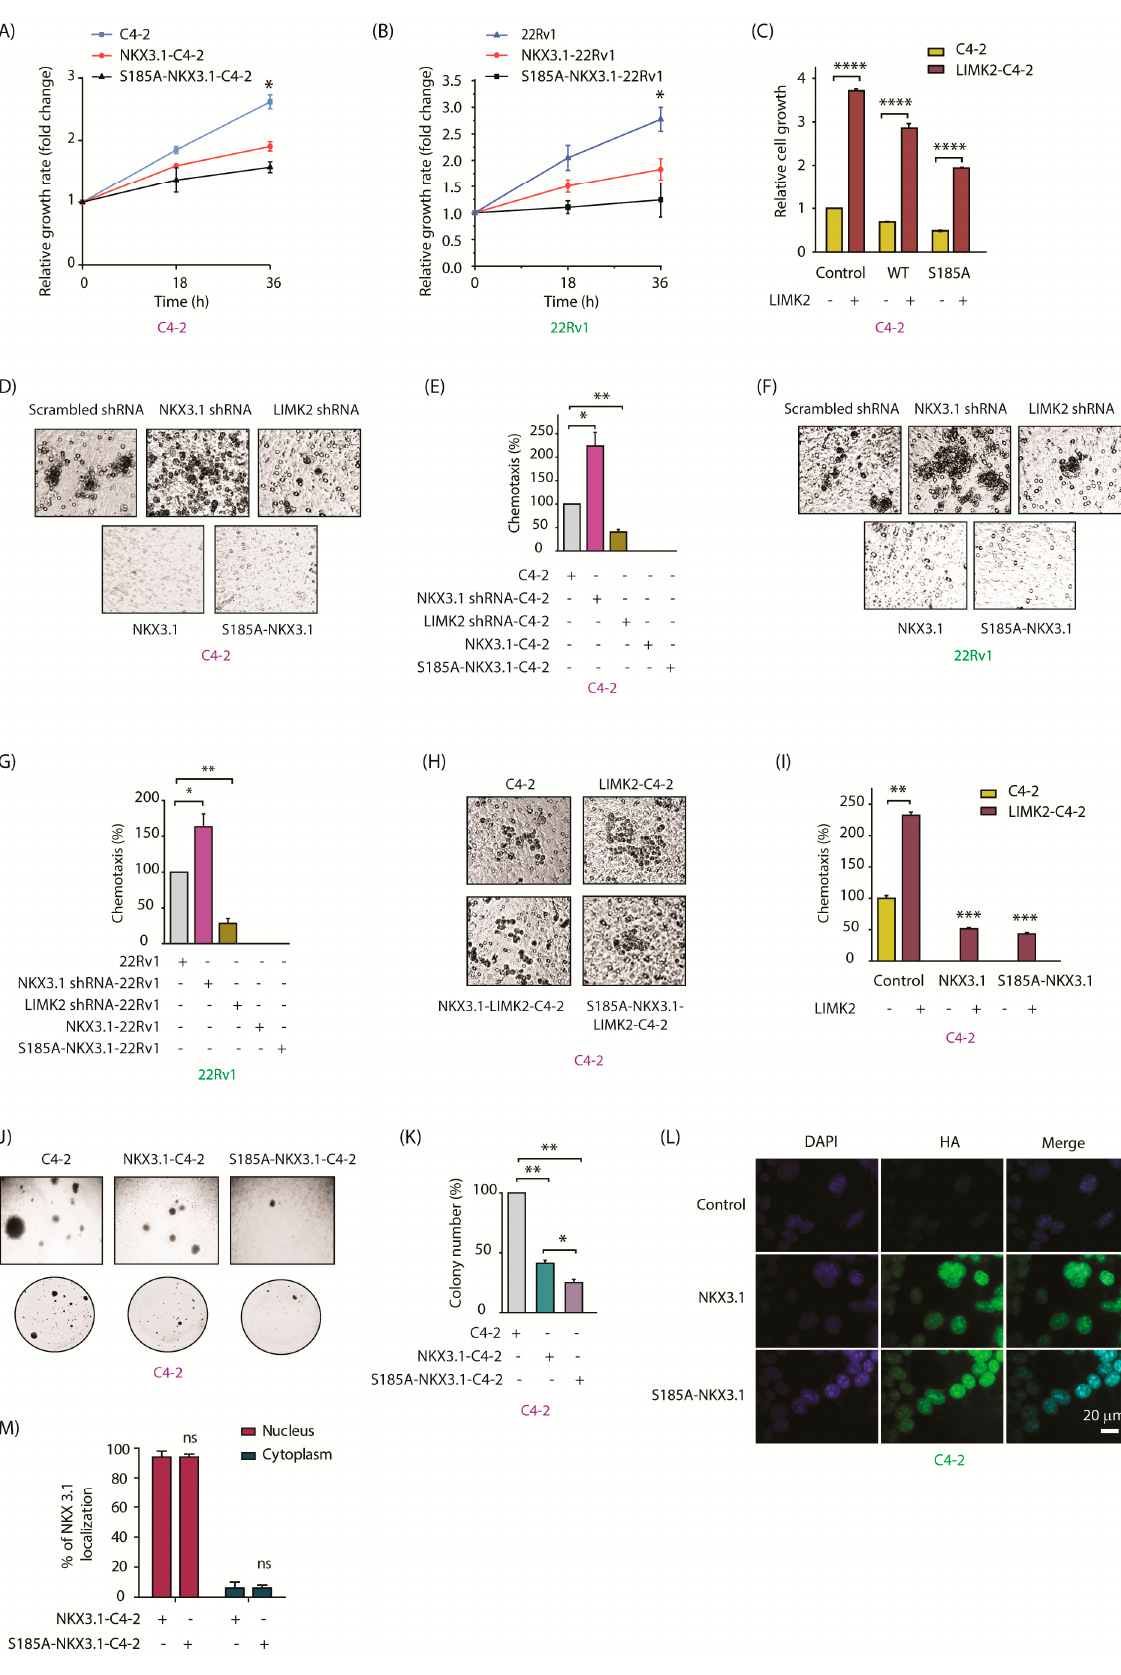
Figure 5. LIMK2-mediated NKX3.1 downregulation promotes oncogenic phenotypes. ( A ) NKX3.1 inhibited cell proliferation in C4-2 and ( B ) 22Rv1 cells. Target cells were seeded in a 24-well plate and infected by NKX3.1 and S185A-NKX3.1